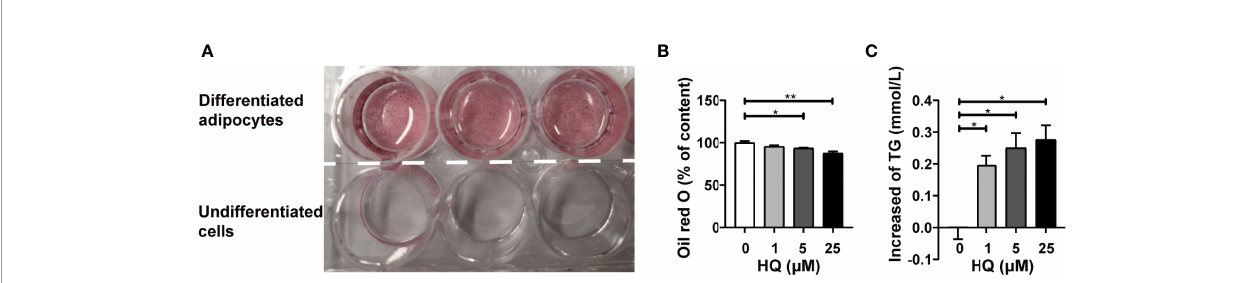
FIGURE 6 | Effect of HQ on 3T3-L1 adipocytes. (A) The adipocytes were successfully differentiated at ID11 and stained with oil red O. The upper three dishes showed mature adipocytes differentiated from preadipocytes 3T3-L1, and the lower three dishes showed undifferentiated cells. The fat content of adipocytes (B) and adipocytes-released TG (C) was determined after 24-hour exposure to HQ. Data are presented as mean ± SD (n = 3-6). One way ANOVA were performed; * p < 0.05, ** p < 0.001 (compared to the control group).